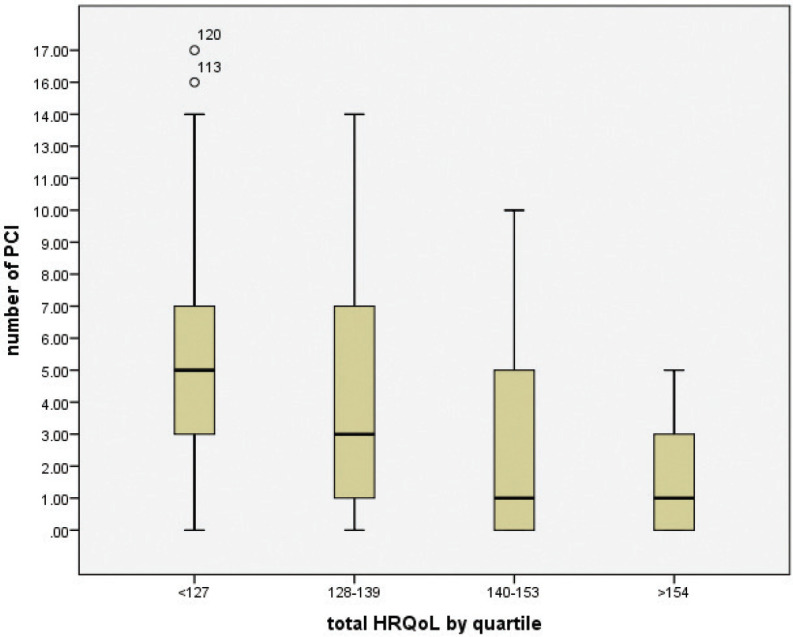
Boxplot of a numbrs of patients’ concern by HRQoL quartile (n = 85).